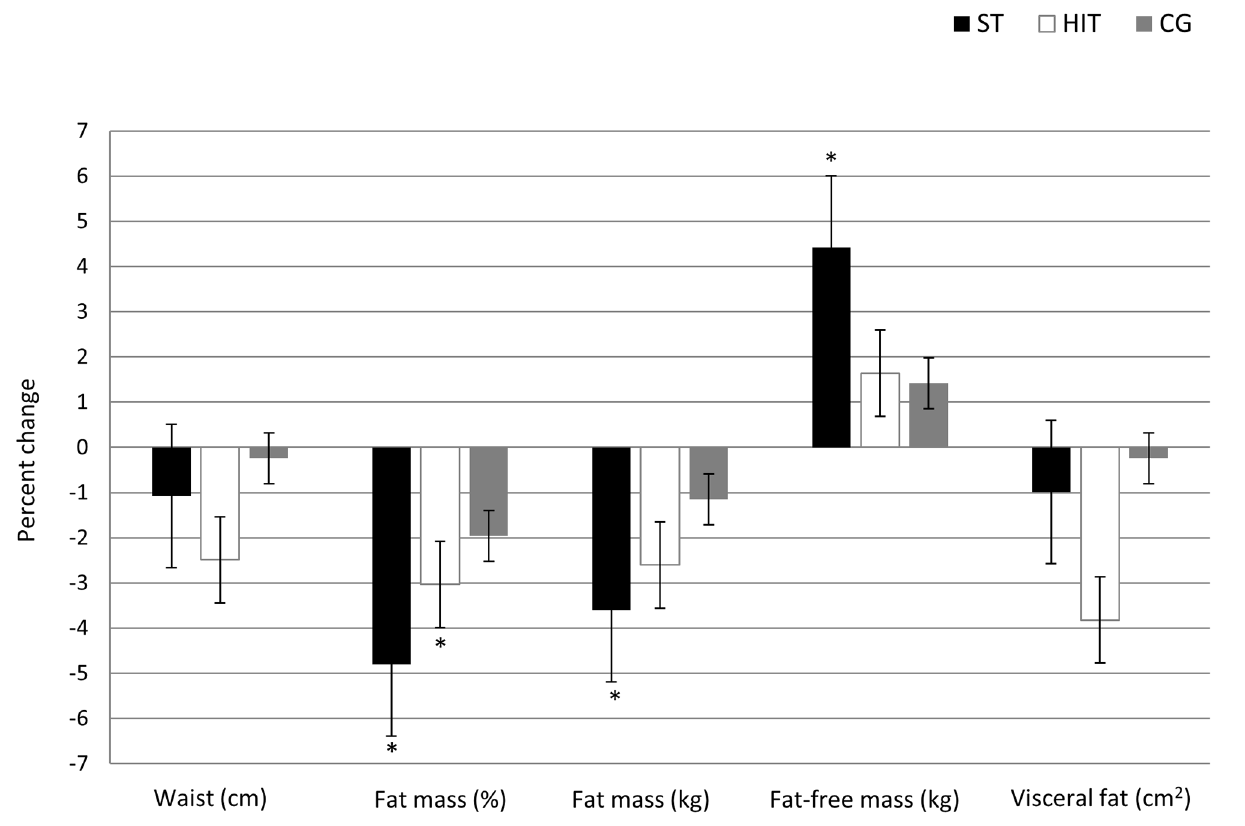
Fig 5. Percent change in body composition from baseline to